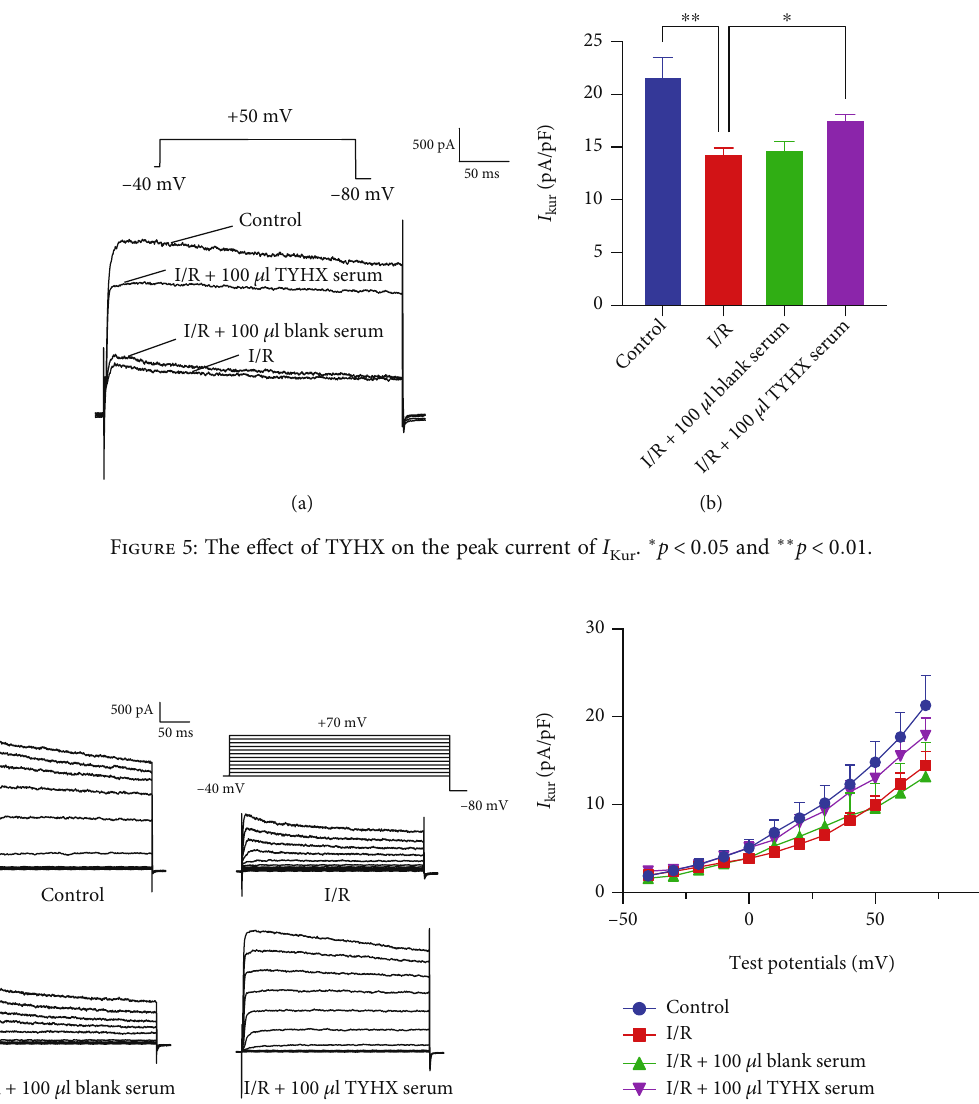
. (a) E ff ect on the I Kur